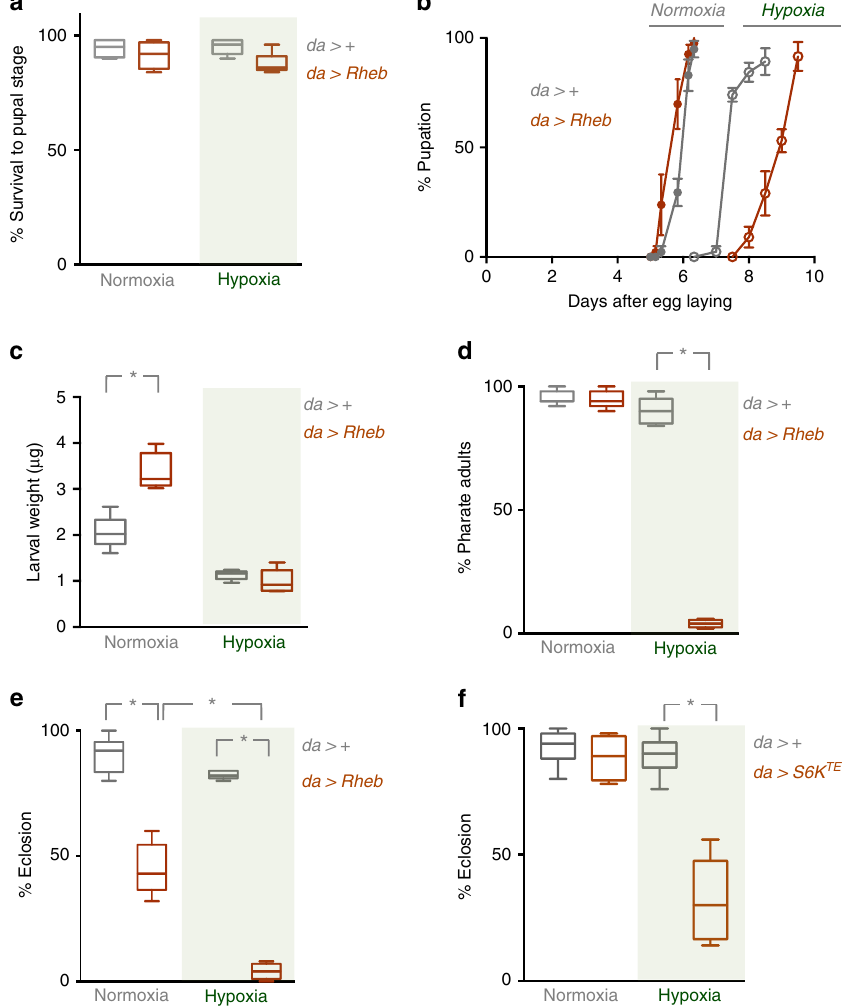
Fig. 3 Suppression of TORC1 is required for adaptation to hypoxia. a – d Control ( da > + ) or Rheb overexpressing ( da > Rheb ) animals were maintained in either normoxia or hypoxia (5% oxygen) throughout the larval period. a Survival to the pupal stage was measured by calculating the percentage or larvae that developed to pupae for each experimental condition. b The rate of larval development was measured by calculating the percentage of animals that progressed to the pupal stage over time. N = a minimum of four independent groups of animals (50/group). Maintaining TORC1 signalling in larvae during hypoxia led to a further delay in pupation. c Weights of wandering third instar larvae were measured for each experimental condition. Maintaining TORC1 signalling in hypoxia did not increase larval growth. Data are presented as box plots (25%, median and 75% values) with error bars indicating the min and max values. N = 5 groups of larvae per condition. d , e Control ( da > + ) or Rheb overexpressing ( da > Rheb ) animals were maintained in either normoxia or hypoxia (5% oxygen) throughout the larval period, before being returned to normoxia at the pupal stage. The percentage of animals that developed to d pharate adults, or e eclosed adults were then calculated. Maintaining TORC1 signalling in larvae during hypoxia led to a subsequent lethality during pupal development. Data are presented as box plots (25%, median and 75% values) with error bars indicating the min and max values. N = fi ve independent groups of animals (50 animals per group) per experimental condition. * p < 0.05, Students t -test. f Control ( da > + ) or S6K TE overexpressing ( da > S6K TE ) animals were maintained in either normoxia or hypoxia (5% oxygen) throughout the larval period, before being returned to normoxia at the pupal stage. The percentage of animals that developed to adults was then calculated. Data are presented as box plots (25%, median and 75% values) with error bars indicating the min and max values. N = a minimum of four independent groups of animals (50 animals per group) per experimental condition. * p < 0.05, Students t